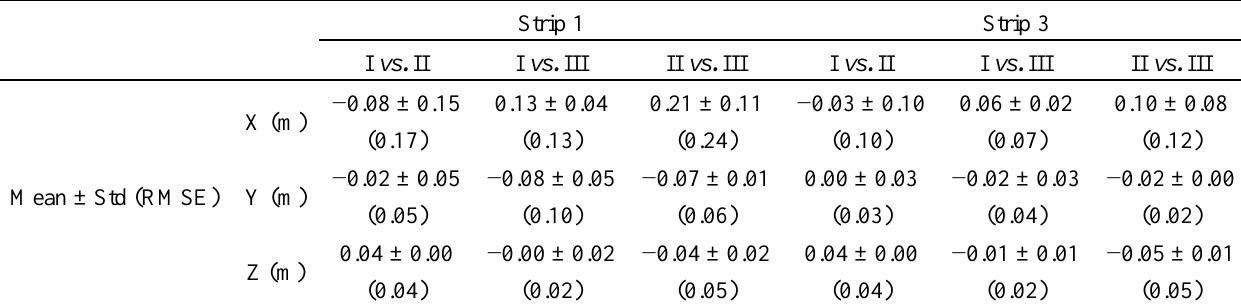
Table 5. RMSE equivalency analysis for the three test scenarios (Simplified